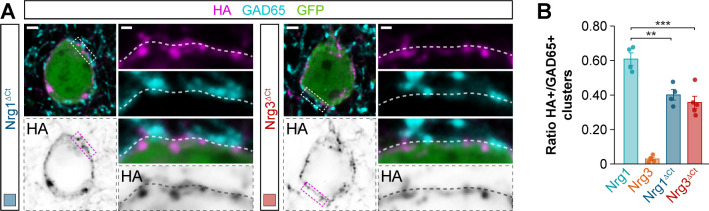
Synaptic targeting of C-terminal domain-lacking neuregulin constructs to inhibitory postsynaptic clusters in the somatic compartment of cortical pyramidal cells.(A) Co-localization of HA-tagged truncated Nrg1ΔCt (left) and HA-tagged truncated Nrg3ΔCt (right) (magenta) with soma-targeting GAD65+ boutons (cyan) in electroporated GFP+ pyramidal cells (green). The bottom panel depicts HA staining in a color-inverted image. The high-magnification images illustrate the localization of HA-tagged neuregulins contacted by presynaptic GAD65+ boutons. (B) Quantification of the proportion of GAD65+ boutons that co-localize with HA-tagged Nrg clusters in the soma of electroporated GFP+ pyramidal cells. Tukey’s range test for post hoc comparison between wild-type Nrg1 construct and chimeric Nrg constructs: **p<0.01, n = 4 mice (34 cells) for pSyn-Nrg1ΔCt-pSyn-Gfp; ***p<0.001, n = 5 mice (43 cells) for pSyn-Nrg3ΔCt-pSyn-Gfp; p=0.739, for comparison between chimeric Nrg constructs. Note that data for Nrg1 and Nrg3 wild-type constructs is the same data shown in Figure 3—figure supplement 3B. Scale bars, 2 μm (A) and 0.5 μm (high magnifications). Data in synaptic quantifications represent mean ± s.e.m. The averages per animal and electroporation condition are shown in bar graphs. Data used for quantitative analyses are available in Figure 6—figure supplement 1—source data 1.
Figure 6—figure supplement 1—source data 1.Numerical data of synaptic targeting of C-terminal domain truncated neuregulin constructs in GFP+ electroporated pyramidal cells.